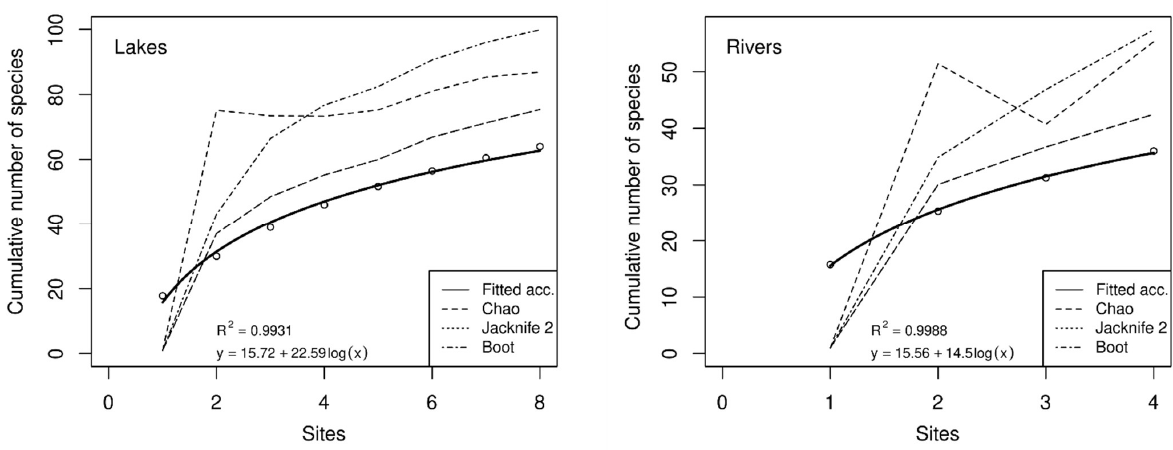
Figure 5. Species accumulation curves and species richness estimators of rotifers in lakes ( left ) and rivers ( right ) in Da Nang.